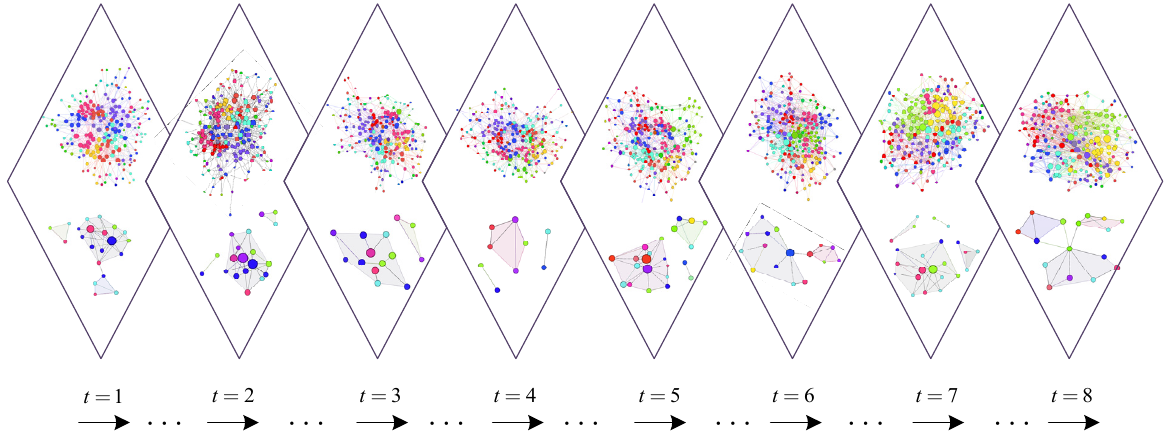
Figure 4. The simulation of the evolution process of an artificial dynamic network.